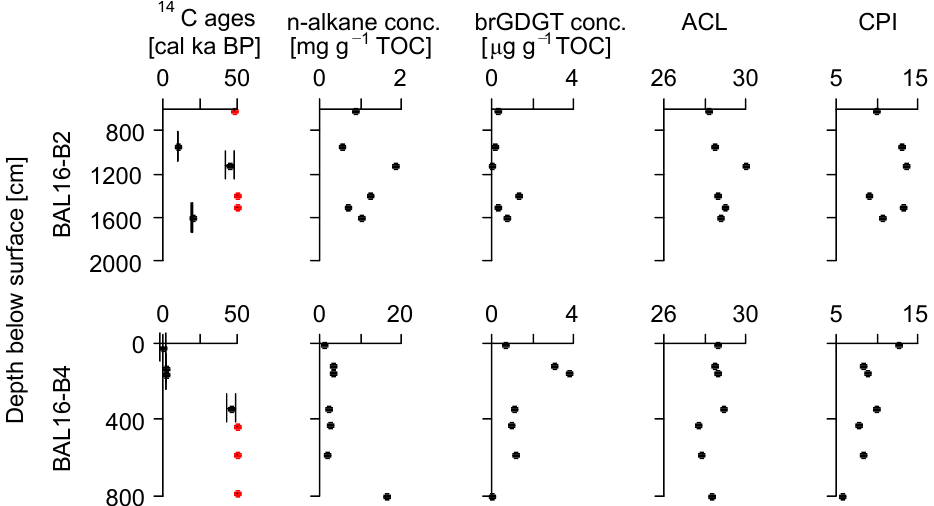
Figure 3. Summary of biomarker parameters of BAL16-B2 (yedoma) and BAL16-B4 (drained thermokarst lake basin): calibrated radio- carbon ages ( 14 C; infinite ages in red), n -alkane concentration, brGDGT concentration, average chain length (ACL) and carbon preference index (CPI). ACL and CPI were calculated from n -alkane range C 23 − 33 . Note: radiocarbon ages are the same as in Fig. 2; different x axes for n -alkane